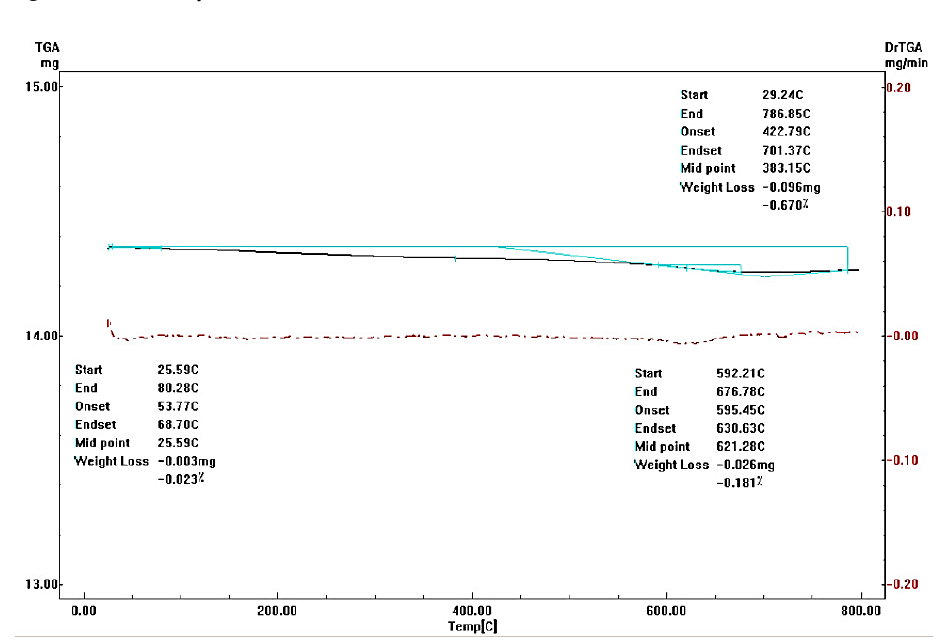
Figure 4. TGA analysis of VA.